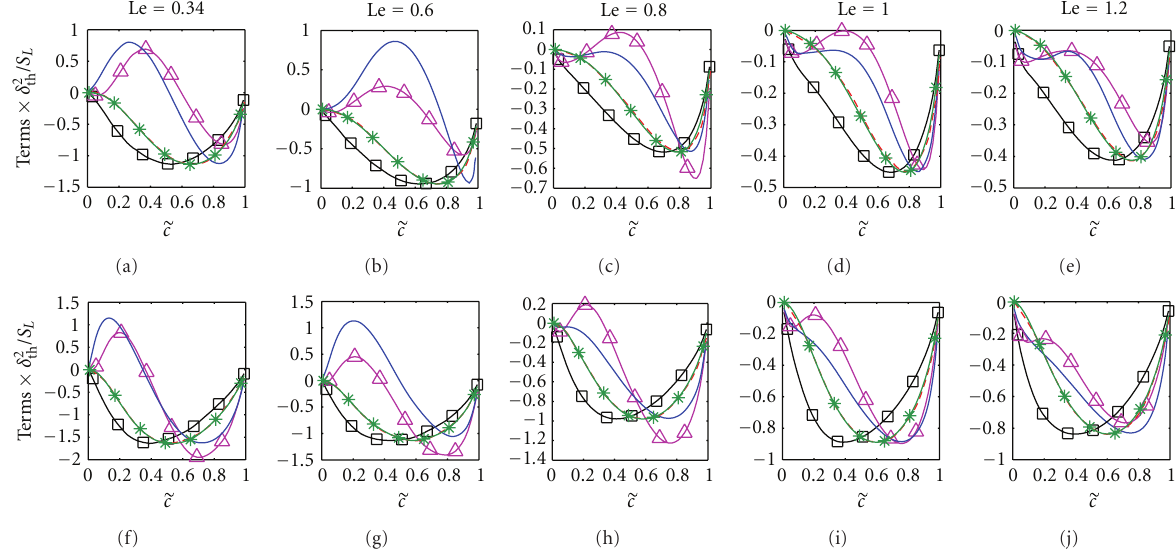
Figure 7: Variation of C sg (solid line) conditionally averaged in bins of (cid:2) c across the flame brush along with the predictions of CSGCAND (asterisk line), CSGCANT (dashed line), CSGCHAR (squared line) and CSGNEW (triangle line) for filter sizes Δ = 8 Δ m ≈ 0 . 8 δ th (top row): (a) Le = 0 . 34 (1st column); (b) Le = 0 . 6 (2nd column); (c) Le = 0 . 8 (3rd column); (d) Le = 1 . 0 (4th column); (e) Le = 1 . 2 (5th column) and for filter size Δ = 24 Δ m ≈ 2 . 4 δ th (bottom row): (f) Le = 0 . 34 (1st column); (g) Le = 0 . 6 (2nd column); (h) Le = 0 . 8 (3rd column); (i) Le = 1 . 0 (4th column); (j) Le = 1 . 2 (5th